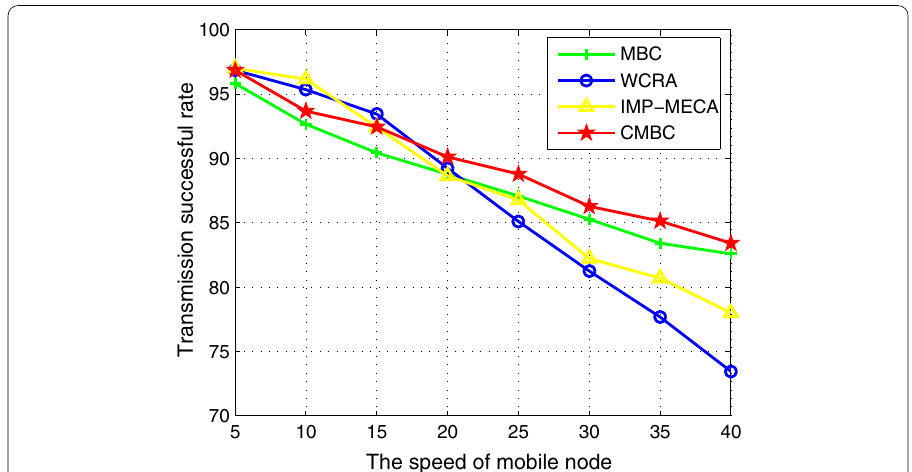
Fig. 8 Results comparison between the speed of mobile node and the transmission success